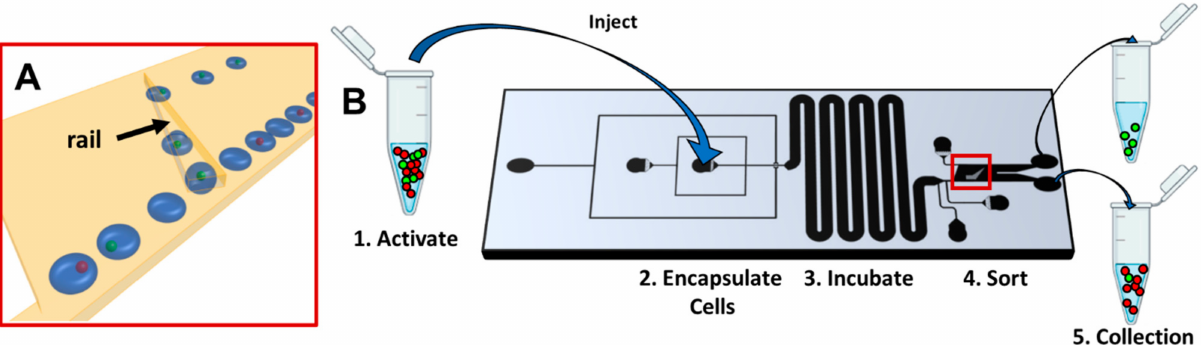
Figure 1. ( A ) Schematic of SIFT sorting mechanism for the population of cells with low (red) and high (green) metabolism. Empty droplets or those containing low metabolism cells are only slightly deflected by the rail. Droplets containing cells with high metabolism are separated as they follow the rail laterally. ( B ) Workflow of the sorting of activated T-cells. Naive T-cells are represented in red and activated T-cells in green. Sorting region indicated by red